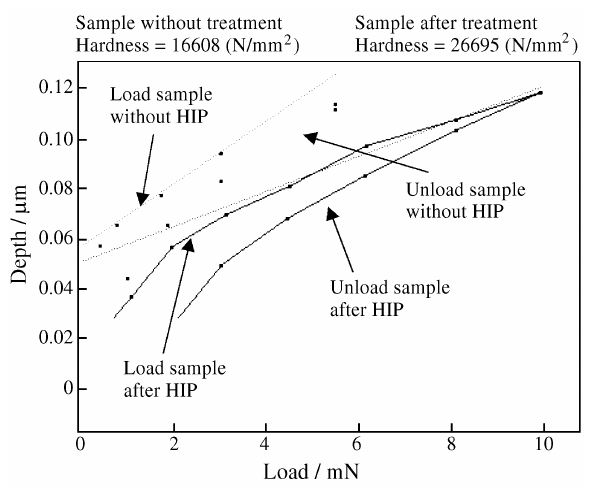
Figure 2. Depth reached by the indenter versus applied load for hardness measurement - maximum depth 0.1 µ m.